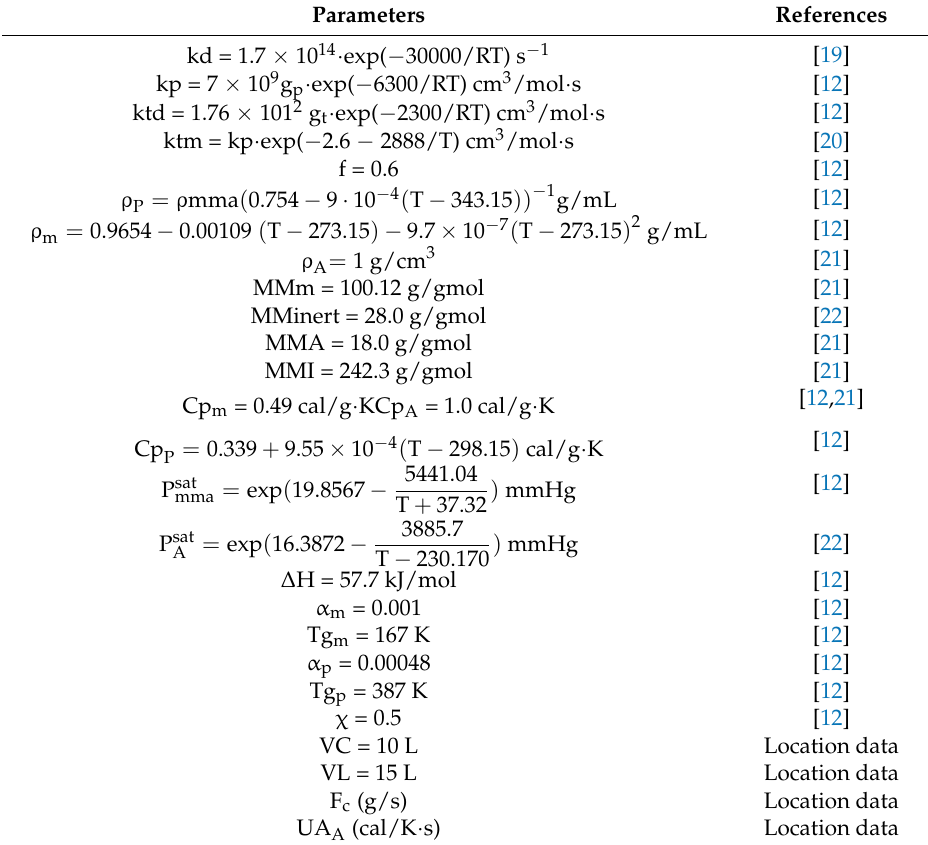
Table 1. Parameters and variables of the mathematical model.